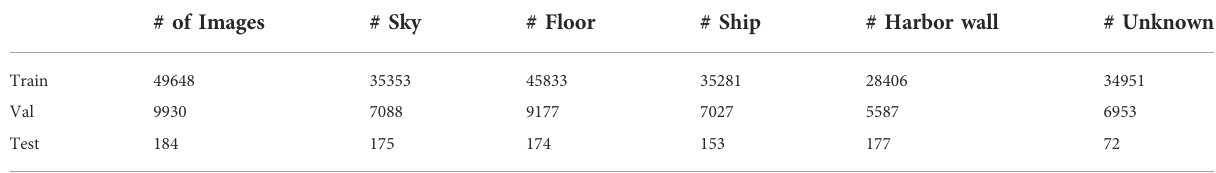
TABLE 3 Dataset used for training (AirSim), validating (AirSim), and testing (Gazebo) our scene semantic segmentation network for shipyard environments. The dataset speci fi cations include the number of images and classes in each partition. # of